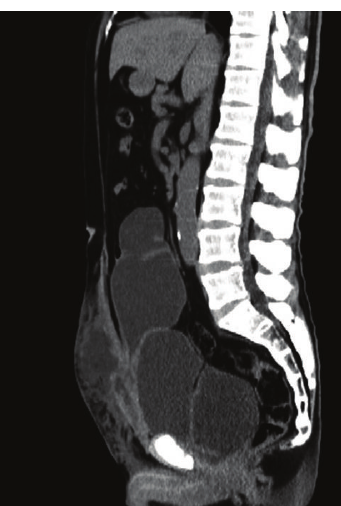
Figure 2: Sagittal unenhanced computed tomography images of the abdomen showing a distended neobladder and subcutaneous fluid accumulation in the lower abdomen. There is no evidence of ascites, intraperitoneal free gas, or incisional herniation.